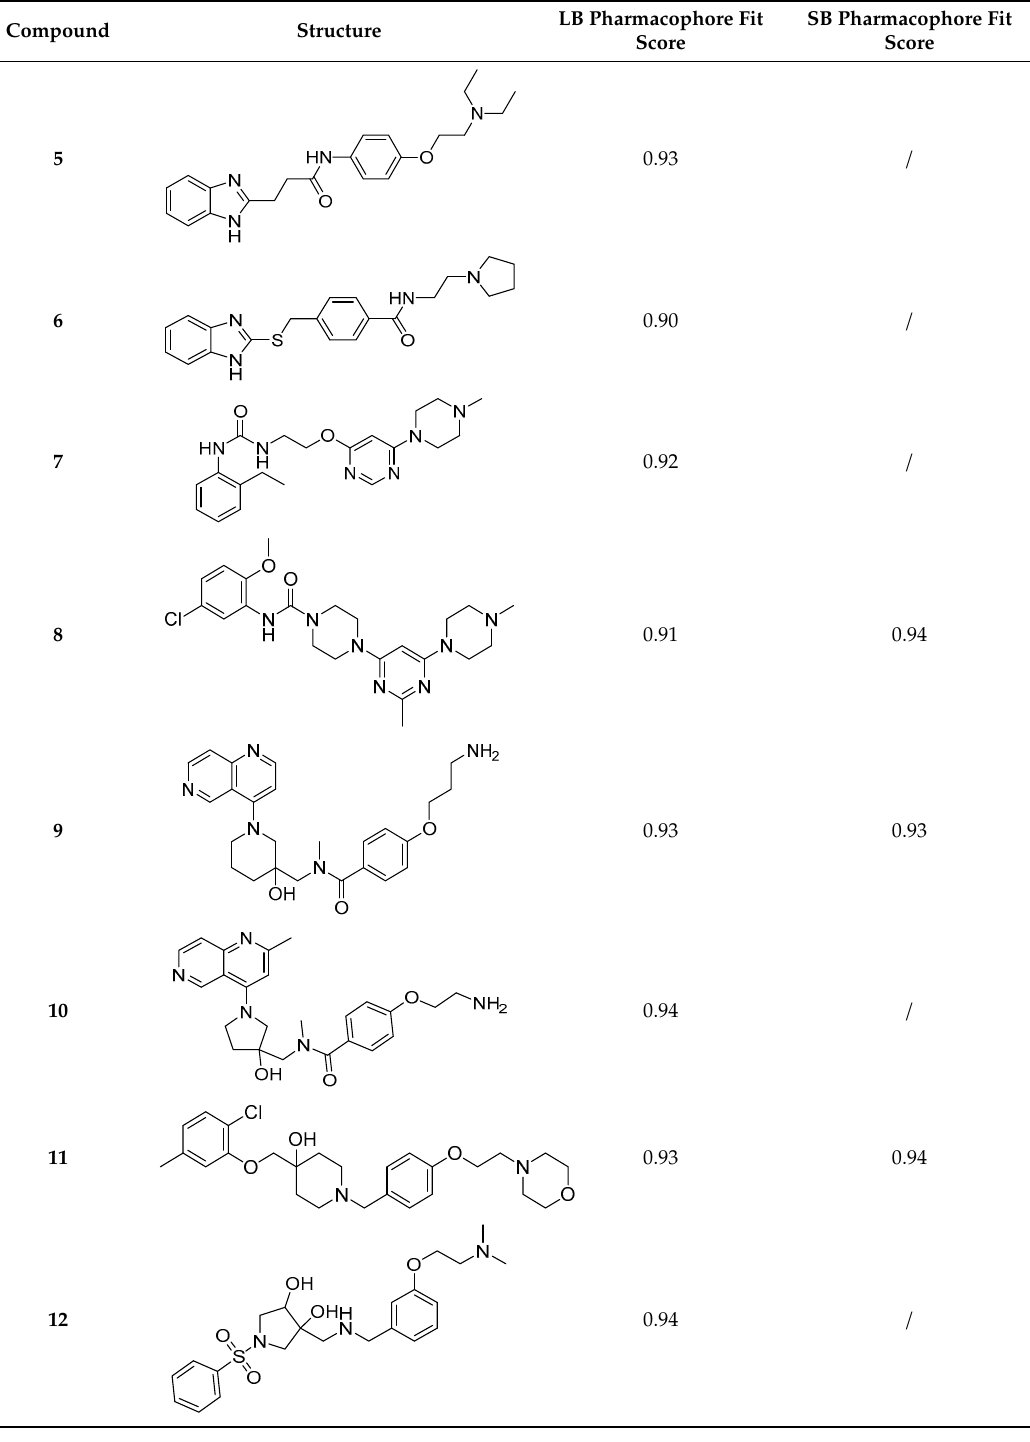
Table 1. Structures of virtual screening hits identified by ligand- and/or structure-based pharmacophore models. Higher pharmacophore fit scores indicate a closer fit to the model. Compounds not retrieved by the SB model are designated with /.